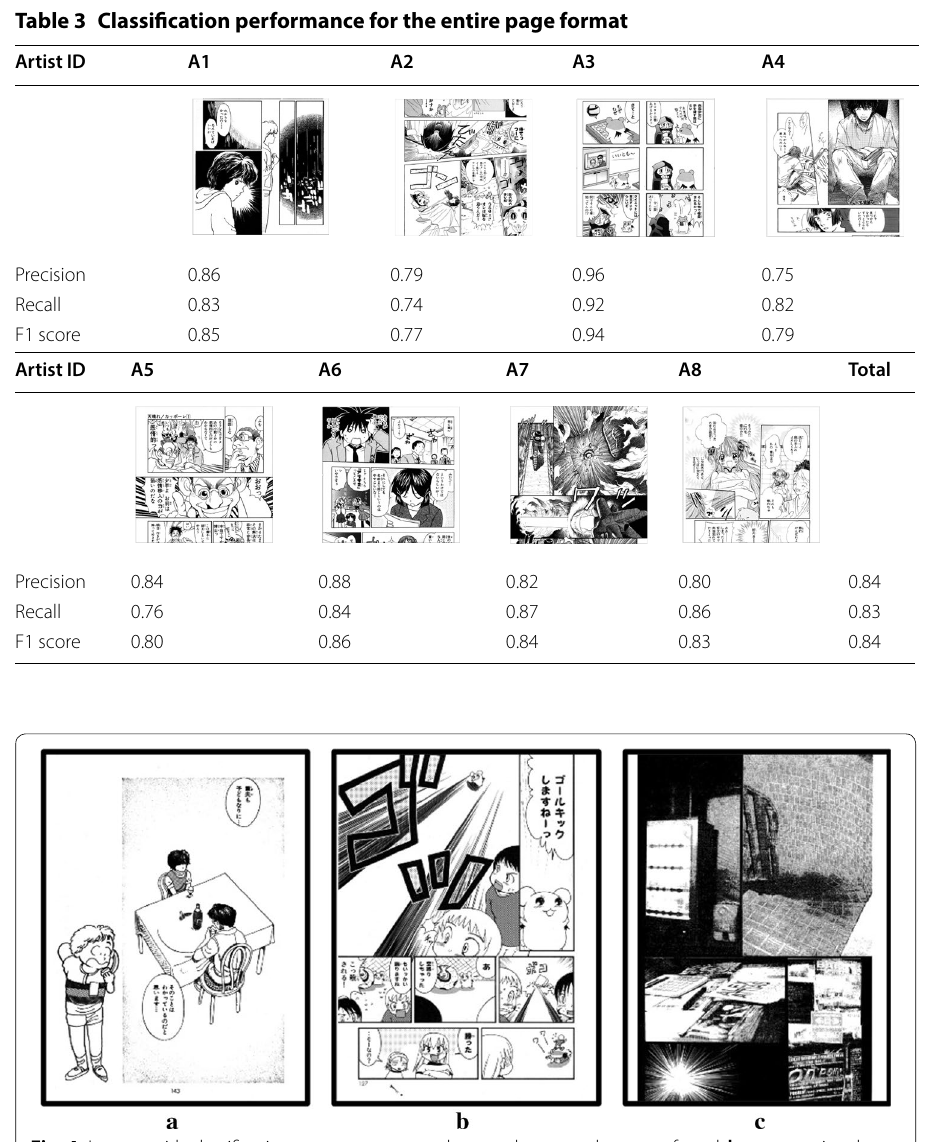
Fig. 4 Images with classification errors: a an unusual page where panels are not found, b an exceptional case of the four cell manga class A3, c an infrequent case including transformed photos